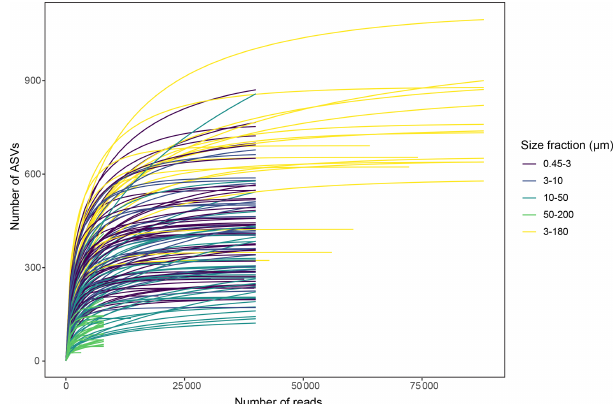
Figure 3. Rarefaction curves for each DNA sample, after subsam- pling to equal number of reads per sample within each size fraction. Unequal number of reads per sample in the 3–180µm fraction was due to low sequencing output in some of these